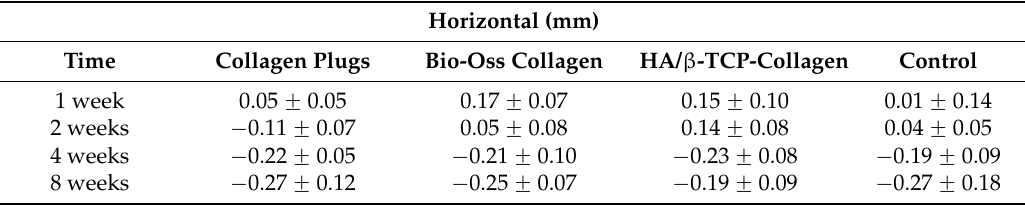
Table 2. Vertical dimensional changes after tooth extraction. Vertical dimensional